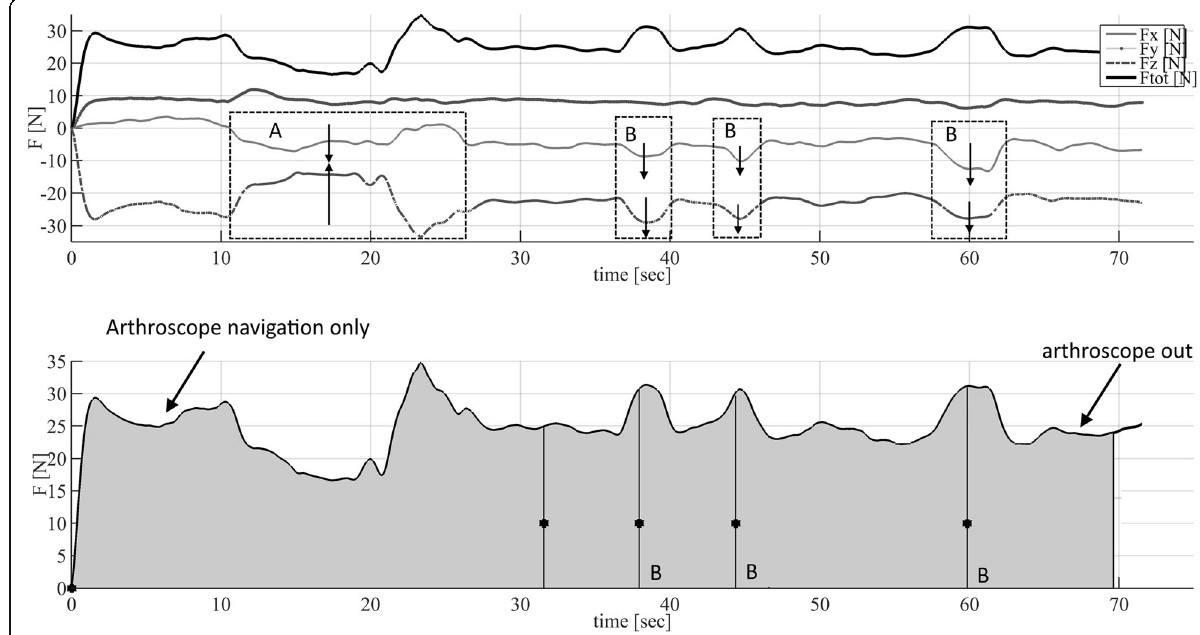
Fig. 3 Example of force measurement in time of one navigation task performed by one expert. This example shows force measurement in time of one navigation task performed by one expert in the posterior compartment. In the upper graph the individual force components as well as the overall combined force F abs are illustrated. In the lower graph the stars indicate the moments of touching and displaying the assigned landmark. In this 2D representation, the first Area (A) represents a location were elbow flexing occurs indicated by an oppositely directed change in Force. The following area ’ s (B) represent instrument bone/tissue interaction with force fluctuations in similar